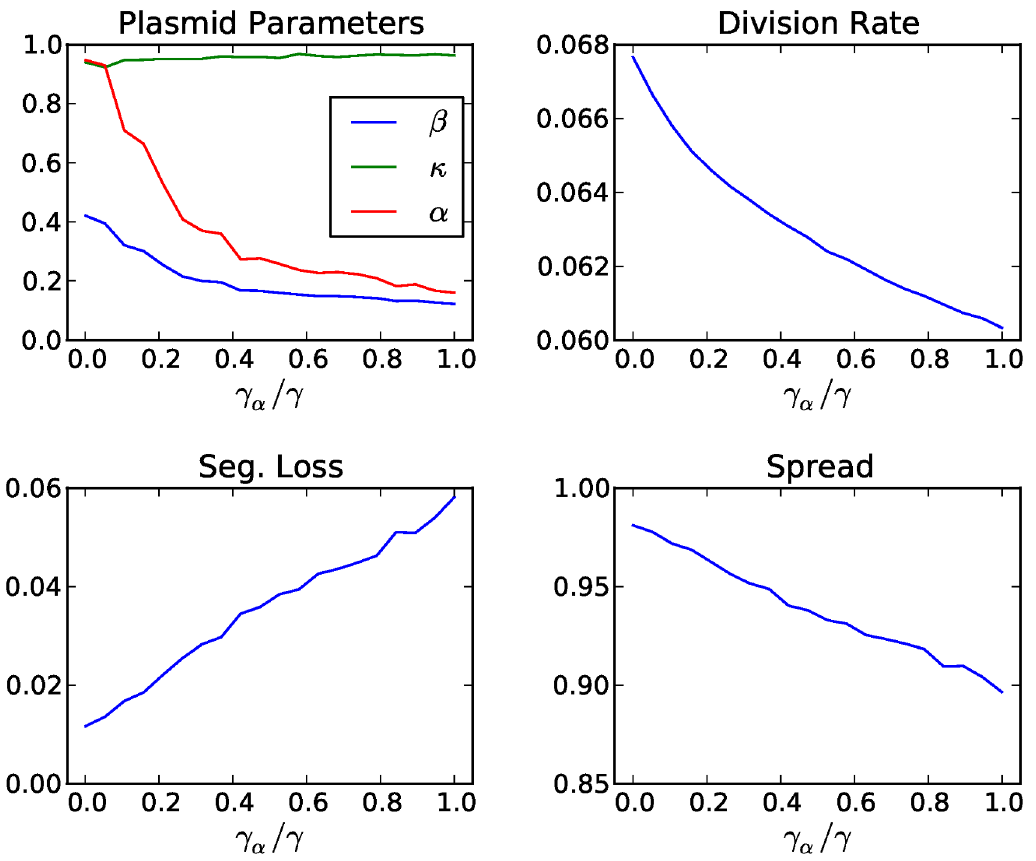
Figure 7. The effects of policing costs on performance metrics and the evolution of CNC. Average values of the plasmid parameters ( b , k , a ), the rates of host division and segregational loss, as well as the fraction of plasmid-infected hosts in the population (plasmid spread) for varying costs of policing. The latter is expressed here as the production cost c a per unit of inhibitor relative to the constant general cost of maintenance c per plasmid copy (e.g. the cost of gene expression, replication etc.).